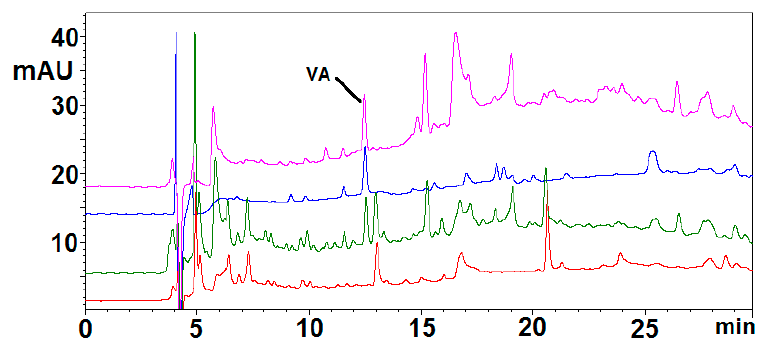
Figure 2. HPLC traces of the IN samples obtained from simulated gastrointestinal digestion of BSP. Green: IN sample from BSP digestion. Blue: ethyl acetate extractable fraction of the IN sample. Red: IN sample from a control mixture containing only enzyme and bile salts (without BSP). Purple: IN sample from BSP digestion without enzyme and bile salts. The chromatographic separation was performed on a ODS column (250 × 4.60 mm, 5 µm), at a flow rate of 0.7 mL/min. The mobile phase was a 1% formic acid (solvent A)/methanol (solvent B) gradient as follows: from 5% to 90% B, 0–45 min.